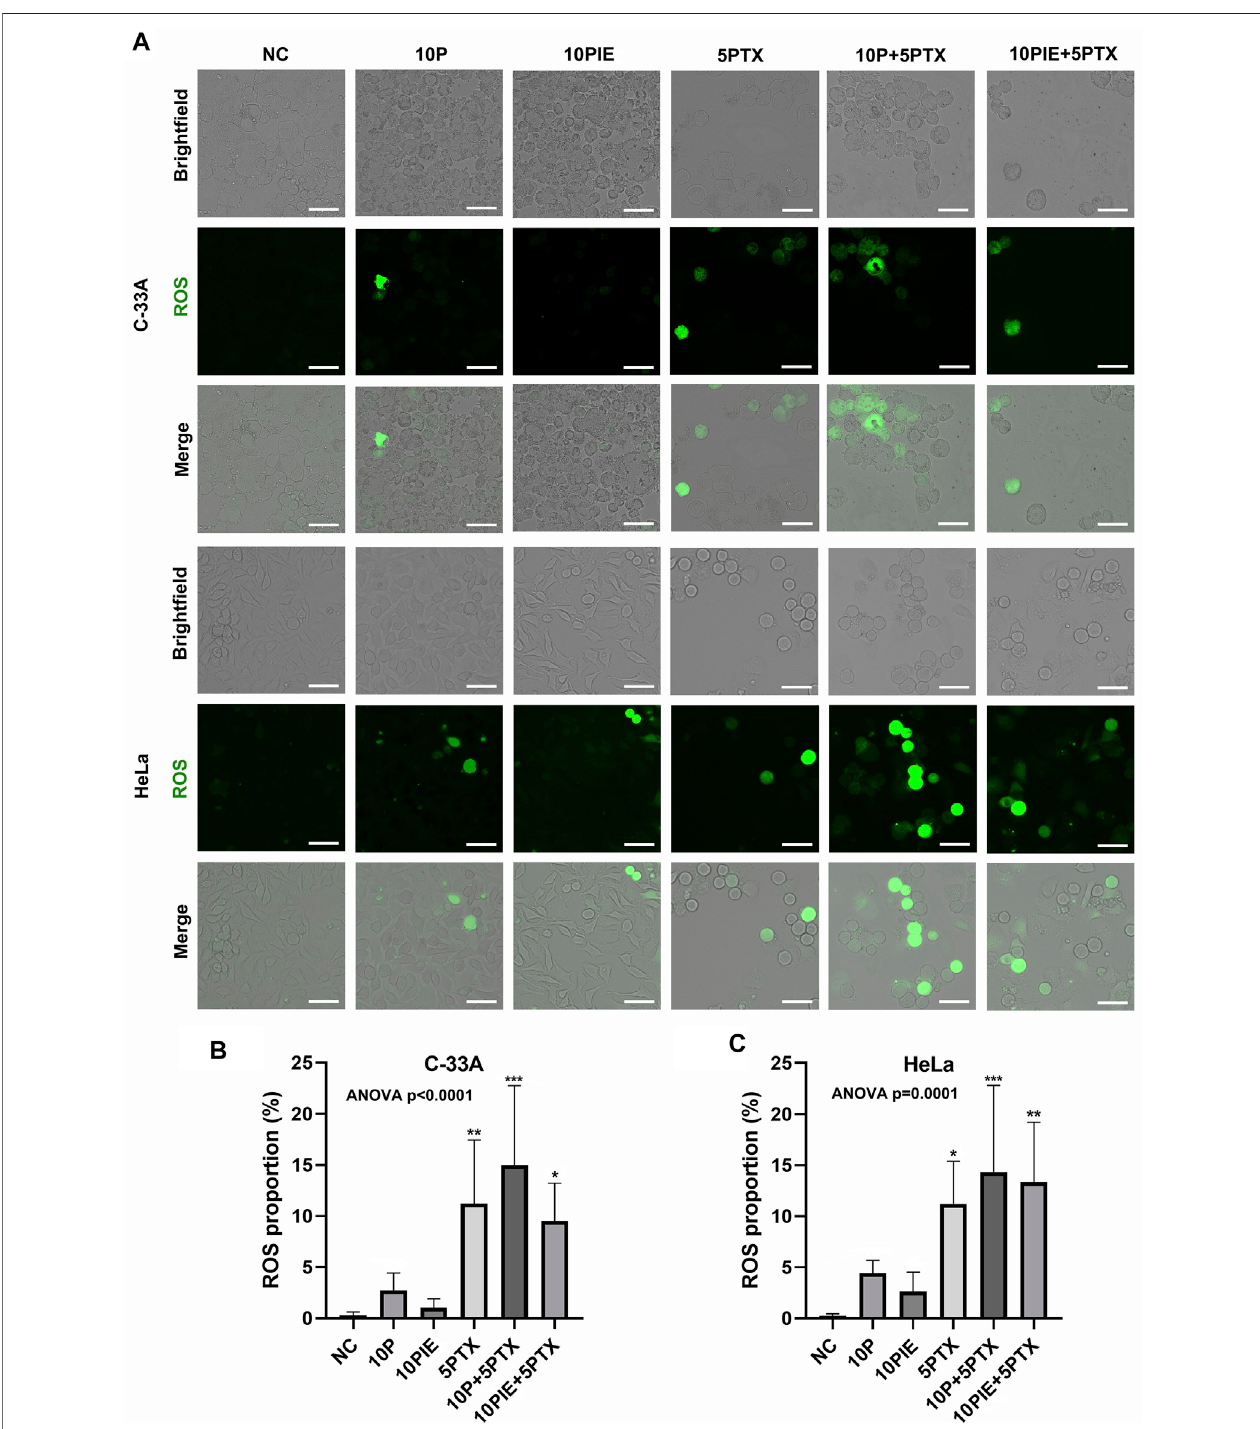
FIGURE 4 | Propofol/PIE plus paclitaxel enhanced cellular ROS in C-33A and HeLa cells. (A) Intracellular ROS was detected via fl uorescent microscopy and indicated as green spots. All the bars indicated 30 µm. (B,C) Statistical analysis of cellular ROS proportion in C-33A and HeLa cells after different combinations of drug treatment. * p < 0.05, ** p < 0.01 and *** p < 0.001 represent statistical signi fi cance.